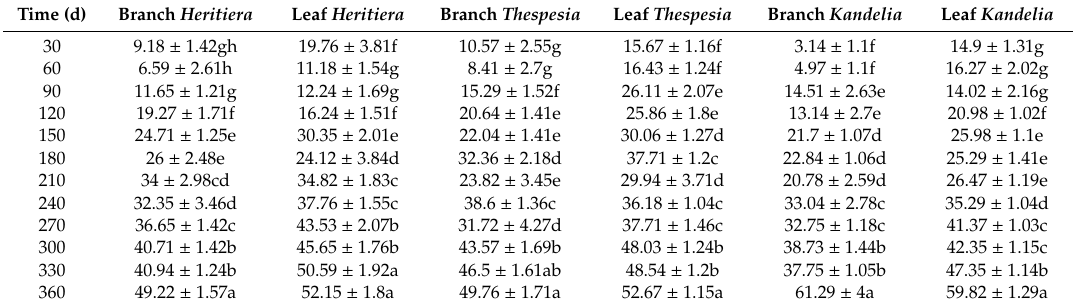
Table 2. Calculated weight loss rate (%) of the leaf and branch portions for the three selected mangrove plant